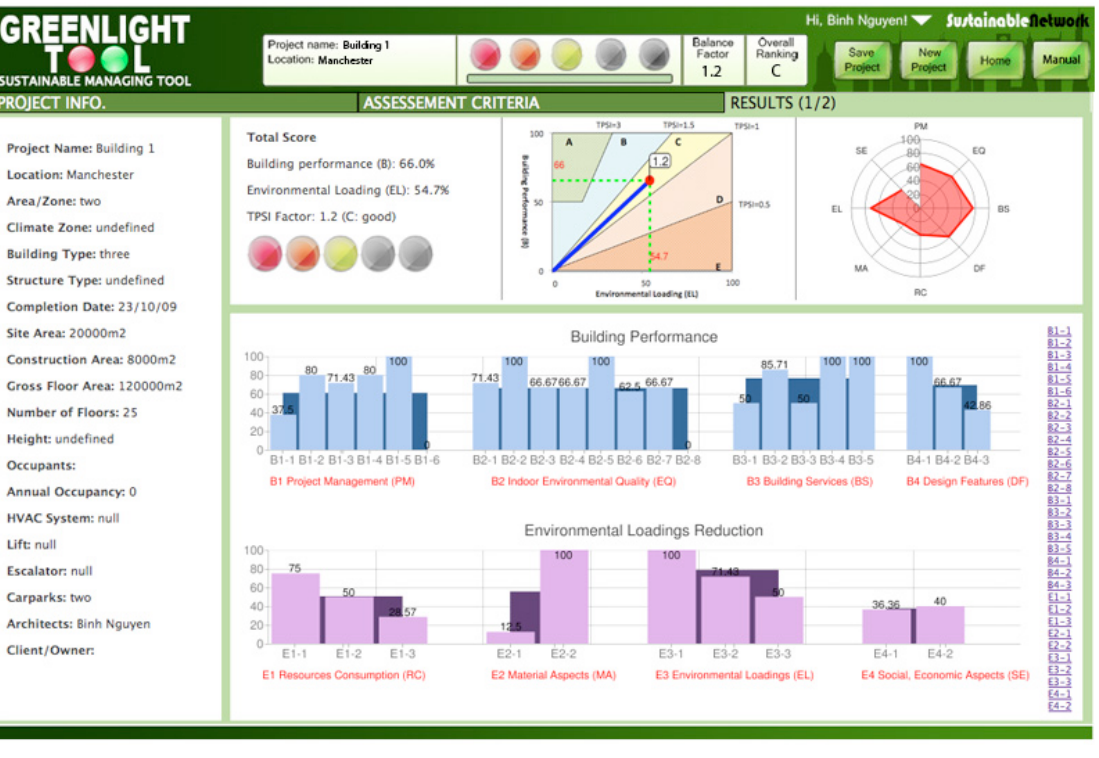
Figure 8. GreenLight Tool—Sample building assessment.